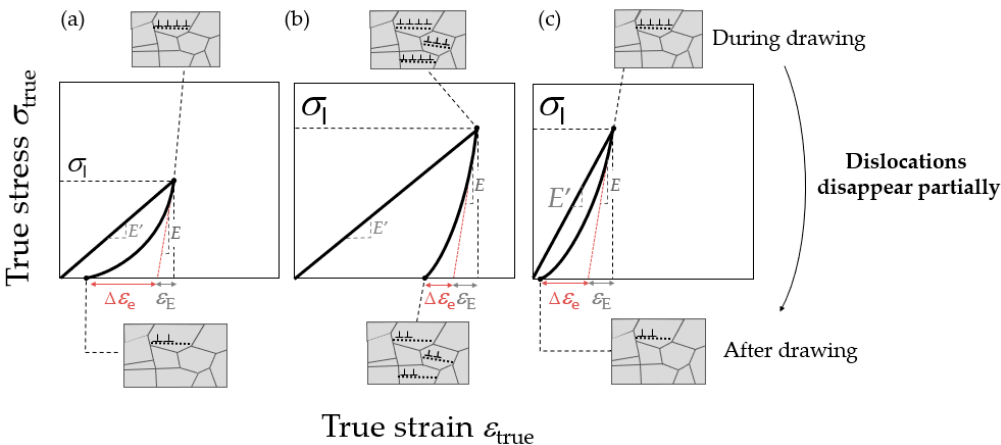
Figure 21. Schematic illustration to explain the physical meaning of the excessive elastic strain Δ ε e . The excessive elastic strain Δ ε e ( a ) at small drawing stress σ l and small apparent elastic modulus E ’, ( b ) at large drawing stress σ l and small apparent elastic modulus E ’, and ( c ) at large drawing stress σ l and large apparent elastic modulus E ’. The parameters E and Δ ε E are the elastic modulus of the bulk metal and the elastic strain, respectively.